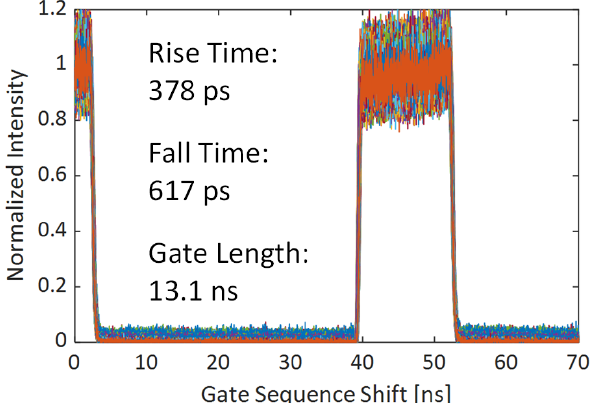
Figure 3. SwissSPAD2 gate window profile. The transition times and the gate width are annotated in the figure. The gate width is user-programmable, and the minimum gate width in the internal laser trigger mode is 10.8 ns. The image is reproduced with permission from Ref. [45], copyright The Authors, published by IOP Publishing Ltd., 2020.